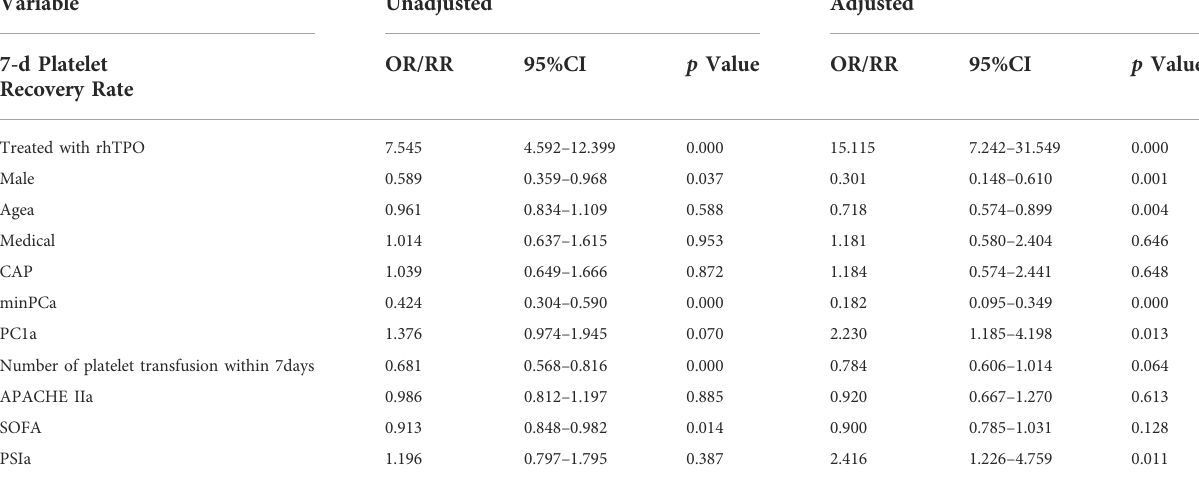
TABLE 4 Multivariate analysis of platelet recovery rate within 7 days.